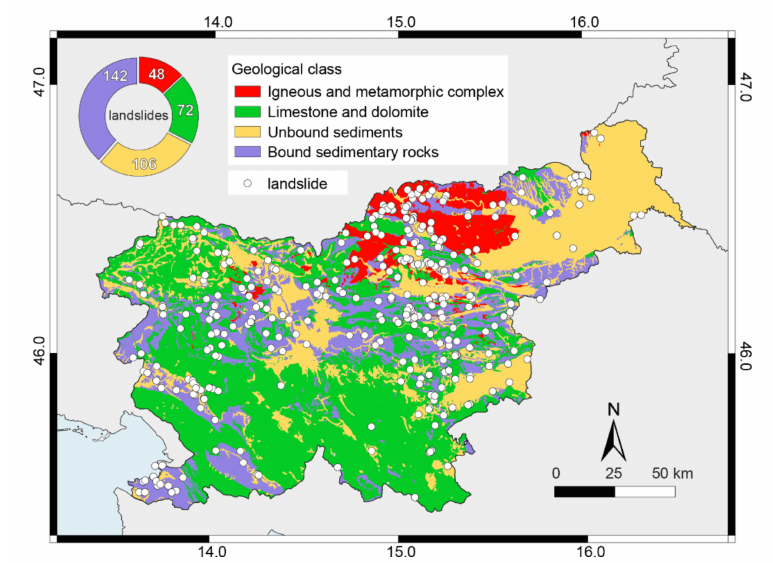
Figure 6. Subdivision of Slovenia into four main lithological classes based on the engineering geological map by Ribiˇciˇc et al. [49], with indication of the landslides used in the analysis. The donut chart shows the number of landslides in each class.